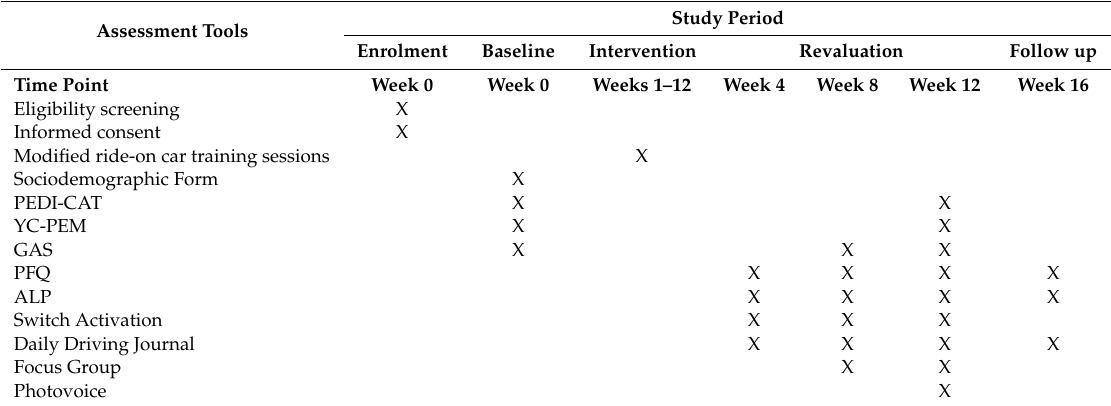
Table 1. Study design